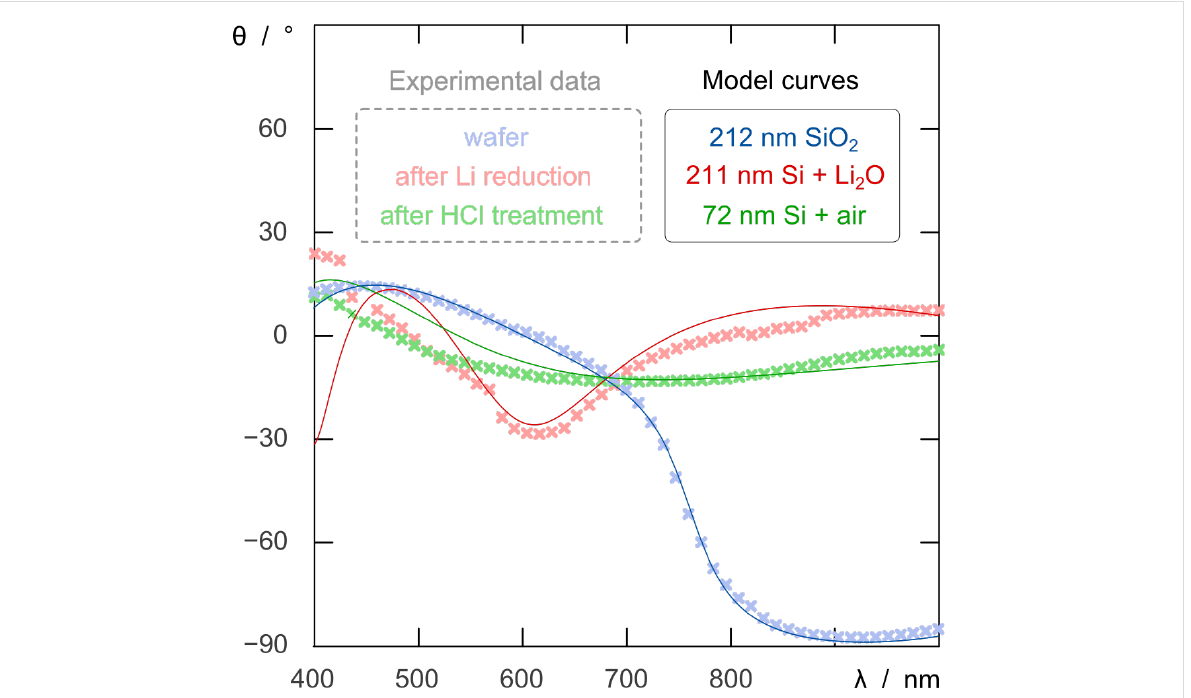
Figure 4: Spectroscopic ellipsometry of flat samples at various stages of preparation: initial substrate with SiO 2 film (blue), after reaction with Li (red), and after acidic treatment and byproduct removal (green). The experimental data are shown as thick, light crosses, whereas the model curves calcu- lated from the corresponding models are drawn as thin, dark lines.